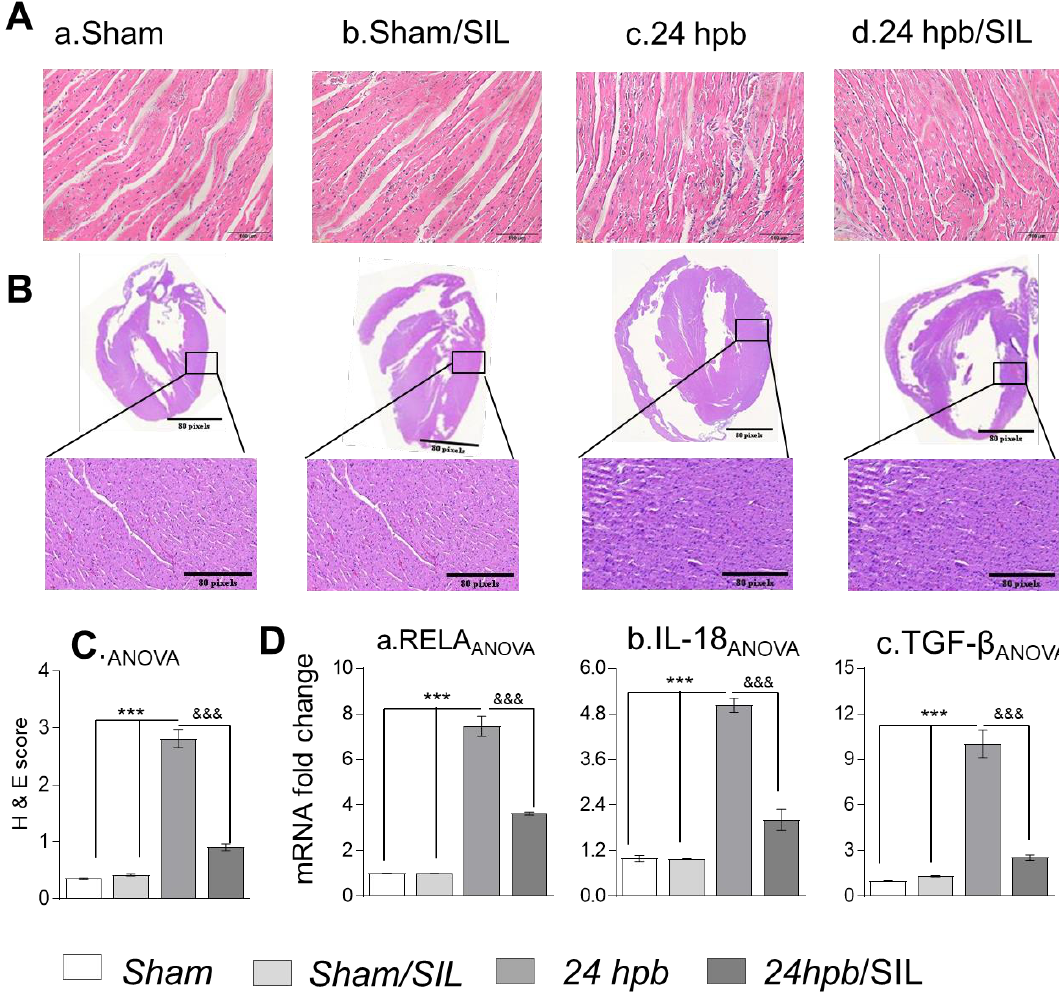
Figure 4. Effect of PDE5 inhibition on myocardial inflammation after a burn. Sprague–Dawley rats were randomized to a 60% TBSA scald burn or sham procedure with standard